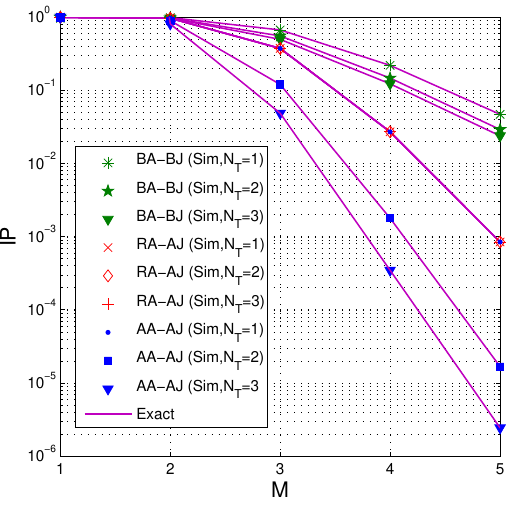
, Figure 7. IP as a function of µ 2 th = 1 0 . 65 , N T = 2 , N E = 3 , K = 4 and M = 5